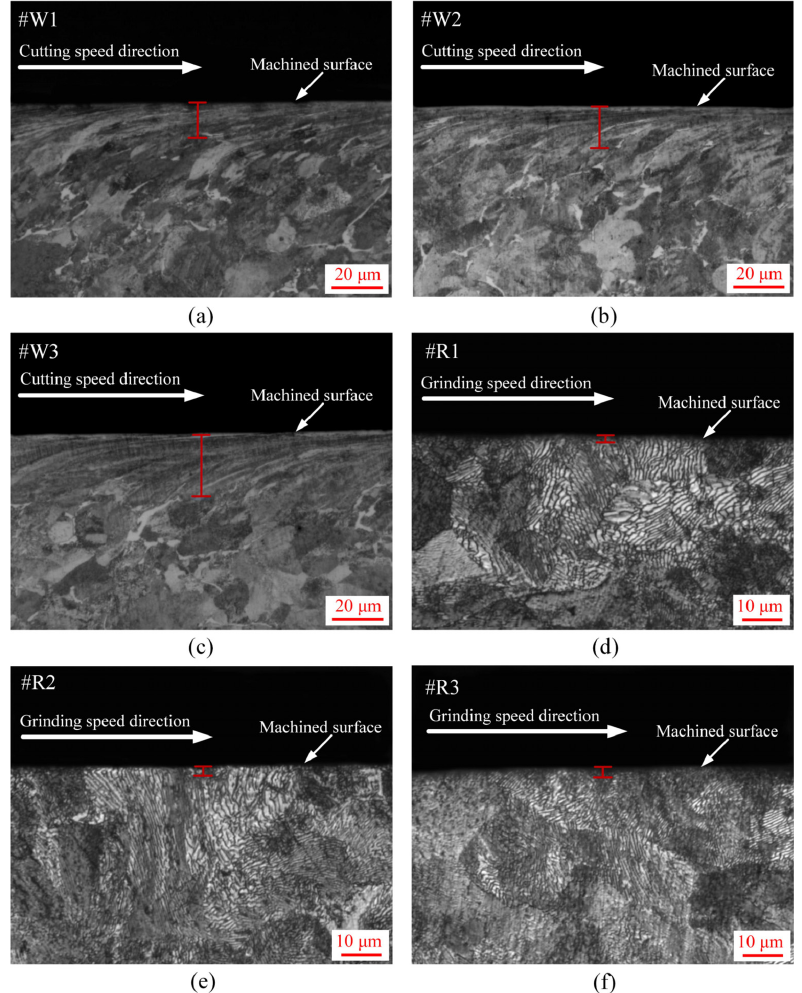
Figure 4. Optical microscope (OM) micrographs of subsurface plastic deformation of wheel/rail samples after machining: ( a ) #W1; ( b ) #W2; ( c ) #W3; ( d ) #R1; ( e ) #R2; ( f ) #R3. after machining: ( a ) #W1; ( b ) #W2; ( c ) #W3; ( d ) #R1; ( e ) #R2; ( f )